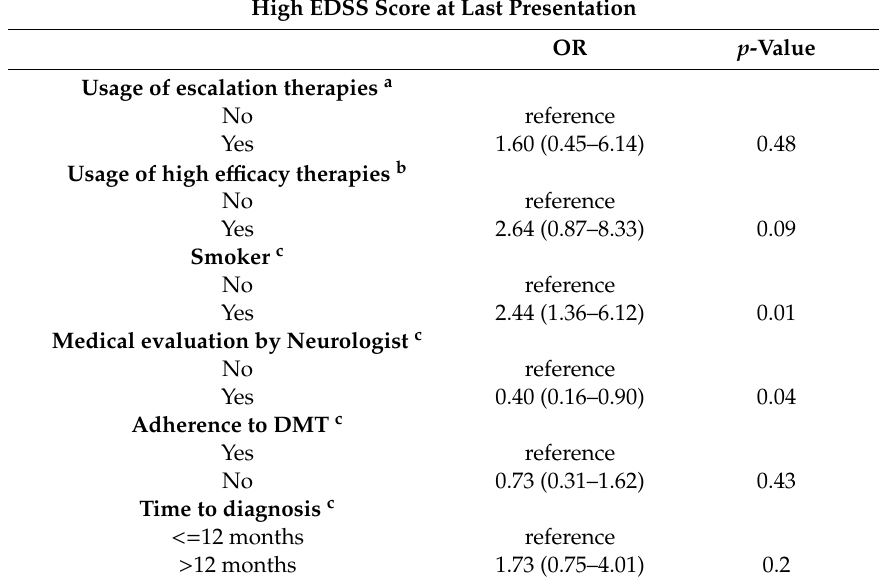
Table 3. Association between various patient characteristics and high EDSS score ( > 4.5) at last presentation.